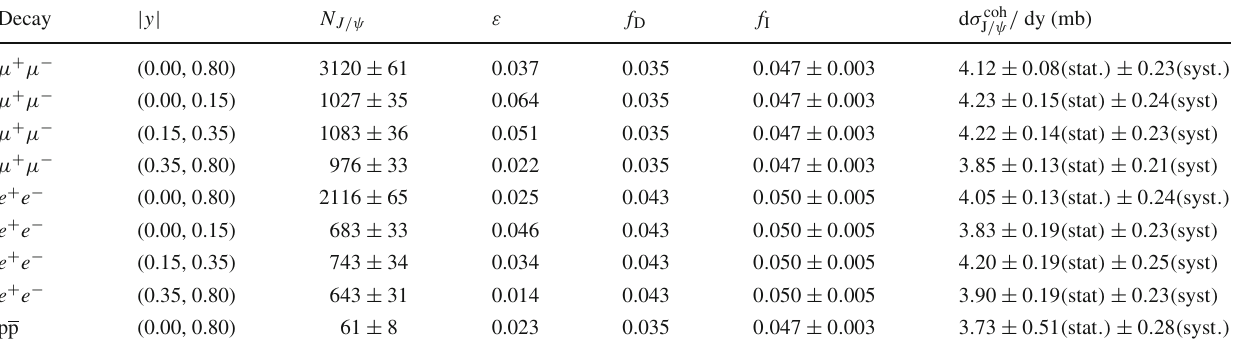
Table 1 Raw J /ψ yields, ε , f D and f I fractions and coherent J /ψ cross sections per decay channel Decay